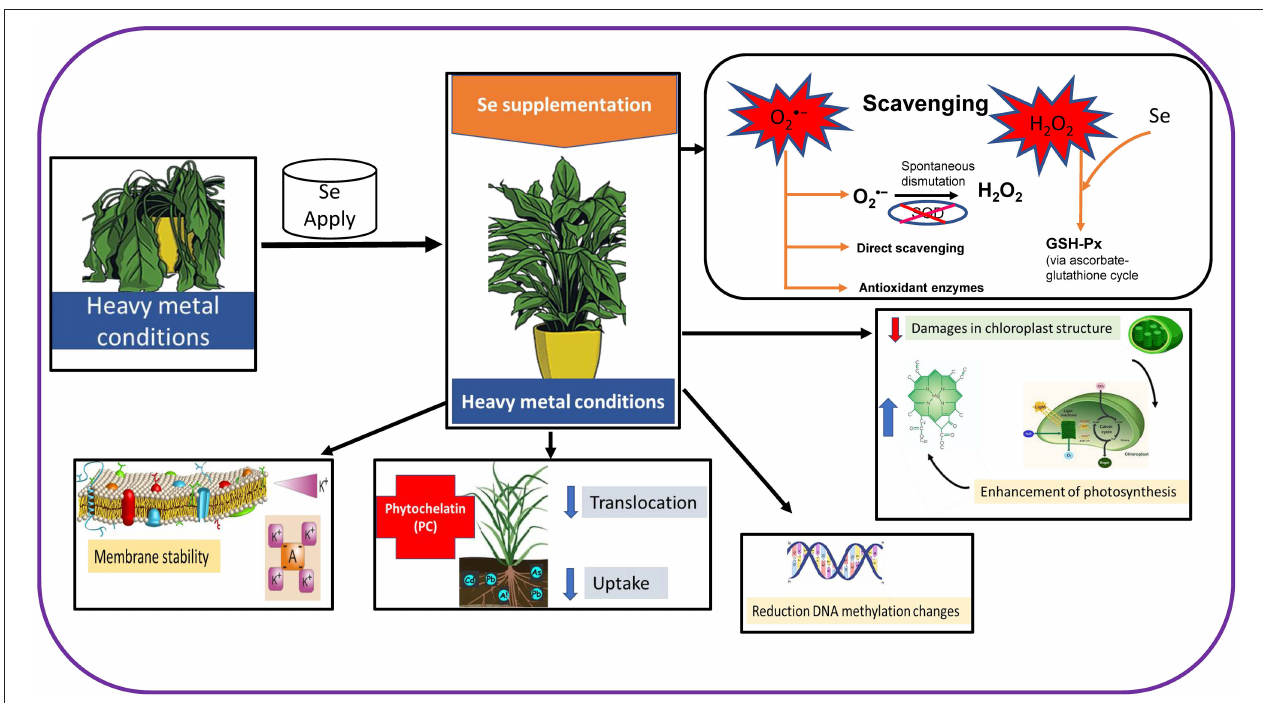
FIGURE 2 | Effects of Se supplementation in plants under heavy metal